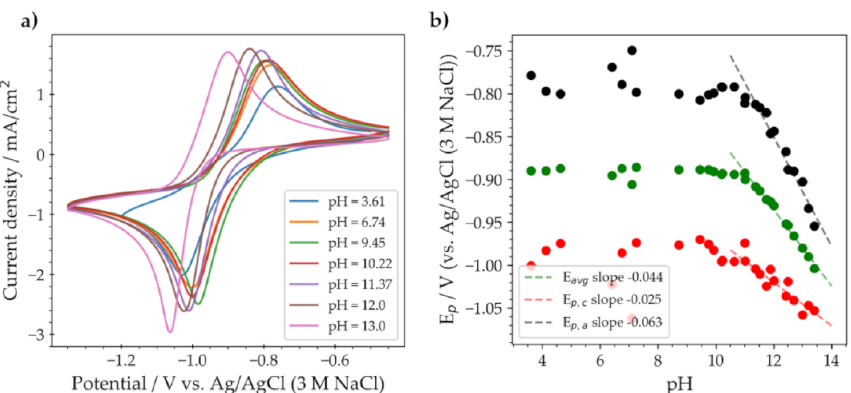
Figure 6. ( a ) Cyclic voltammograms of a 5 mM solution of QUI 6 in unbuffered solution of 1 M KCl at different pHs. ( b ) The resulting potential-pH diagram shows the reduction (red), average (green), and oxidation (black) peak potentials. The voltammograms were recorded at a scan rate of 100 mV/s using a 3 mm diameter glassy carbon disk electrode.